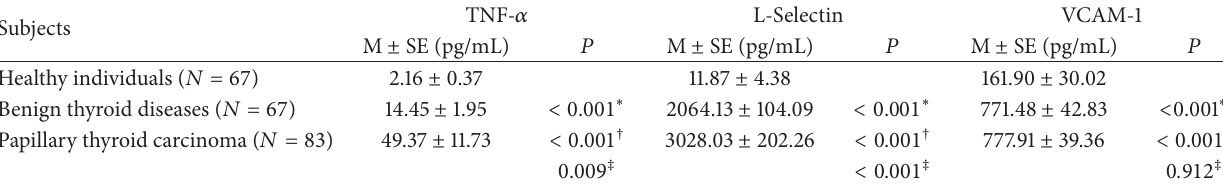
Table 2: Significance of circulating levels of TNF- 𝛼 , L-Selectin, and VCAM-1 in patients with benign thyroid diseases and PTC.